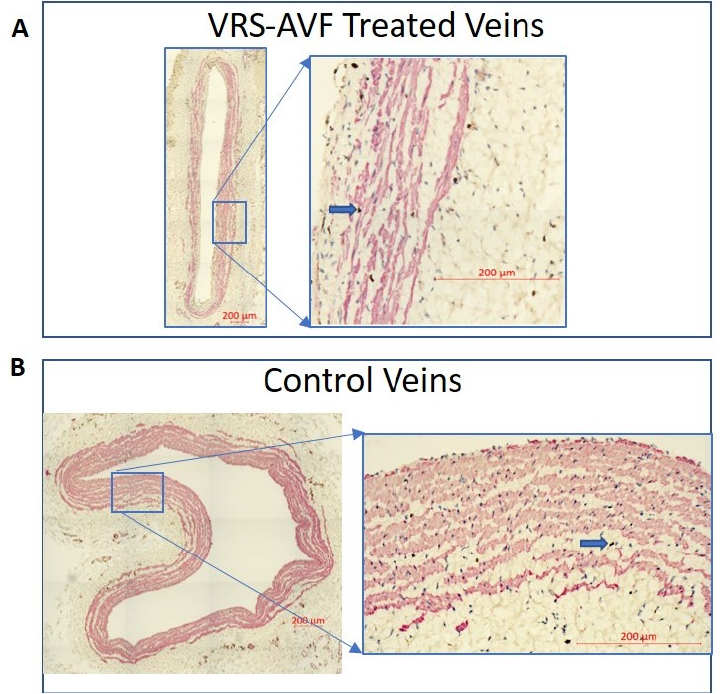
Figure 3. Evidence of Facilitated Outward Remodeling Following VRS-AVF Treatment (Ki67 and smooth muscle cell staining). Representative immunohistochemistry images of venous wall cross sections from fistulas collected 1 week following surgery. The upper panel ( A ) illustrates the VRS-AVF treated vein. Ki67 positive staining (dark brown dots, blue arrows) demonstrates the presence of more proliferating cells than can be seen in the control vein, lower panel ( B ). Smooth muscle actin (SMA) was stained red.